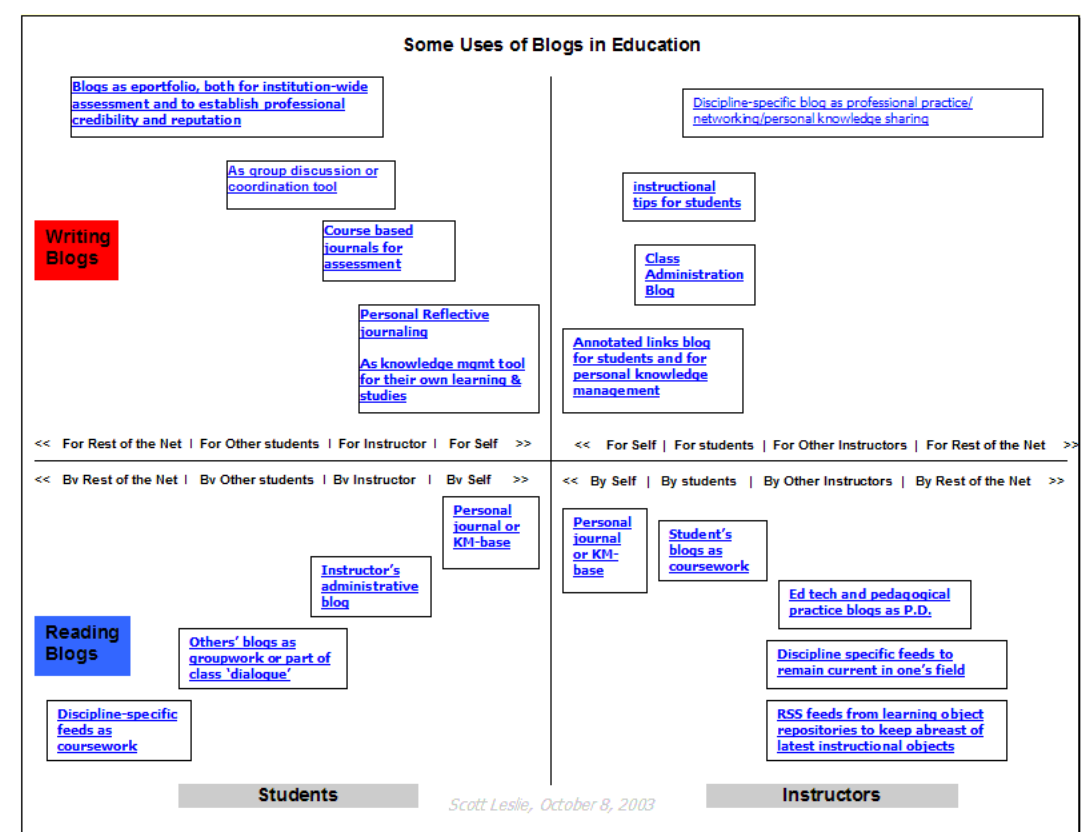
Figure 1. “Leslie Matrix (Leslie,